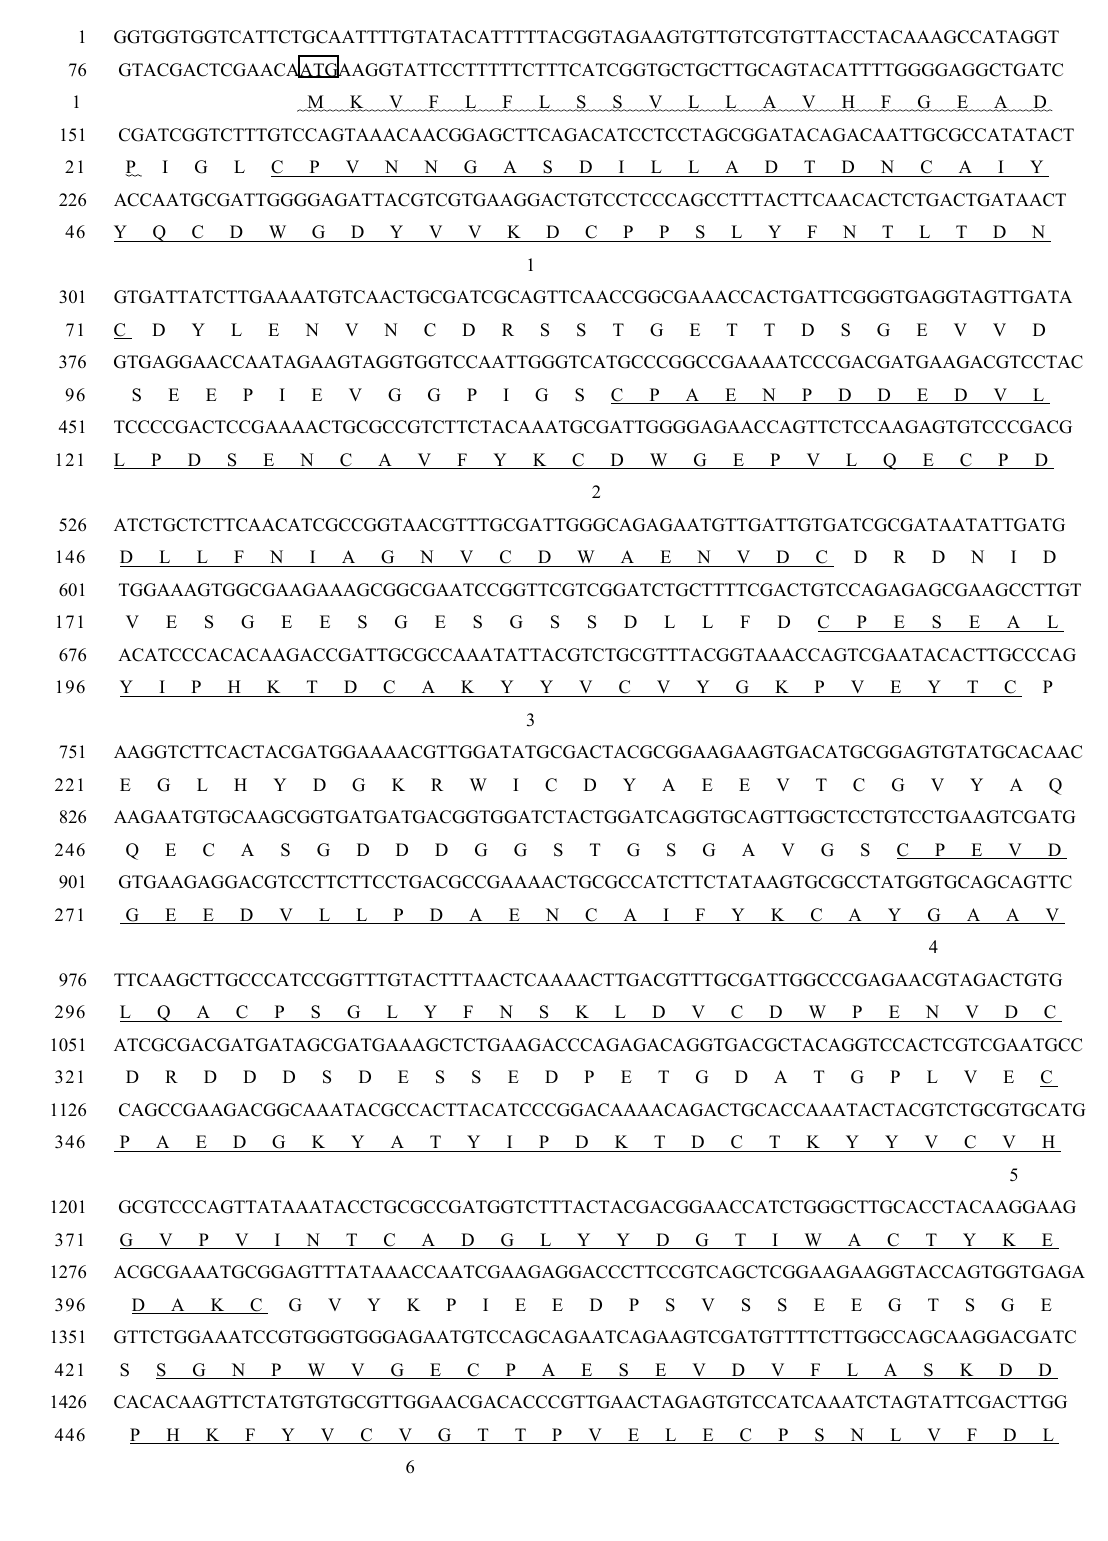
Figure 1. Nucleotide sequences of the cDNA for HpCBP45 and its deduced amino acid sequences. The translation initiation codon ATG and stop codon TAA are in box. The predicted signal peptide cleavage site is wavy underlined. eight chitin binding domains, peritrophin-A domains, are underlined and numbered from 1 to 8 from N - to C -terminus of the